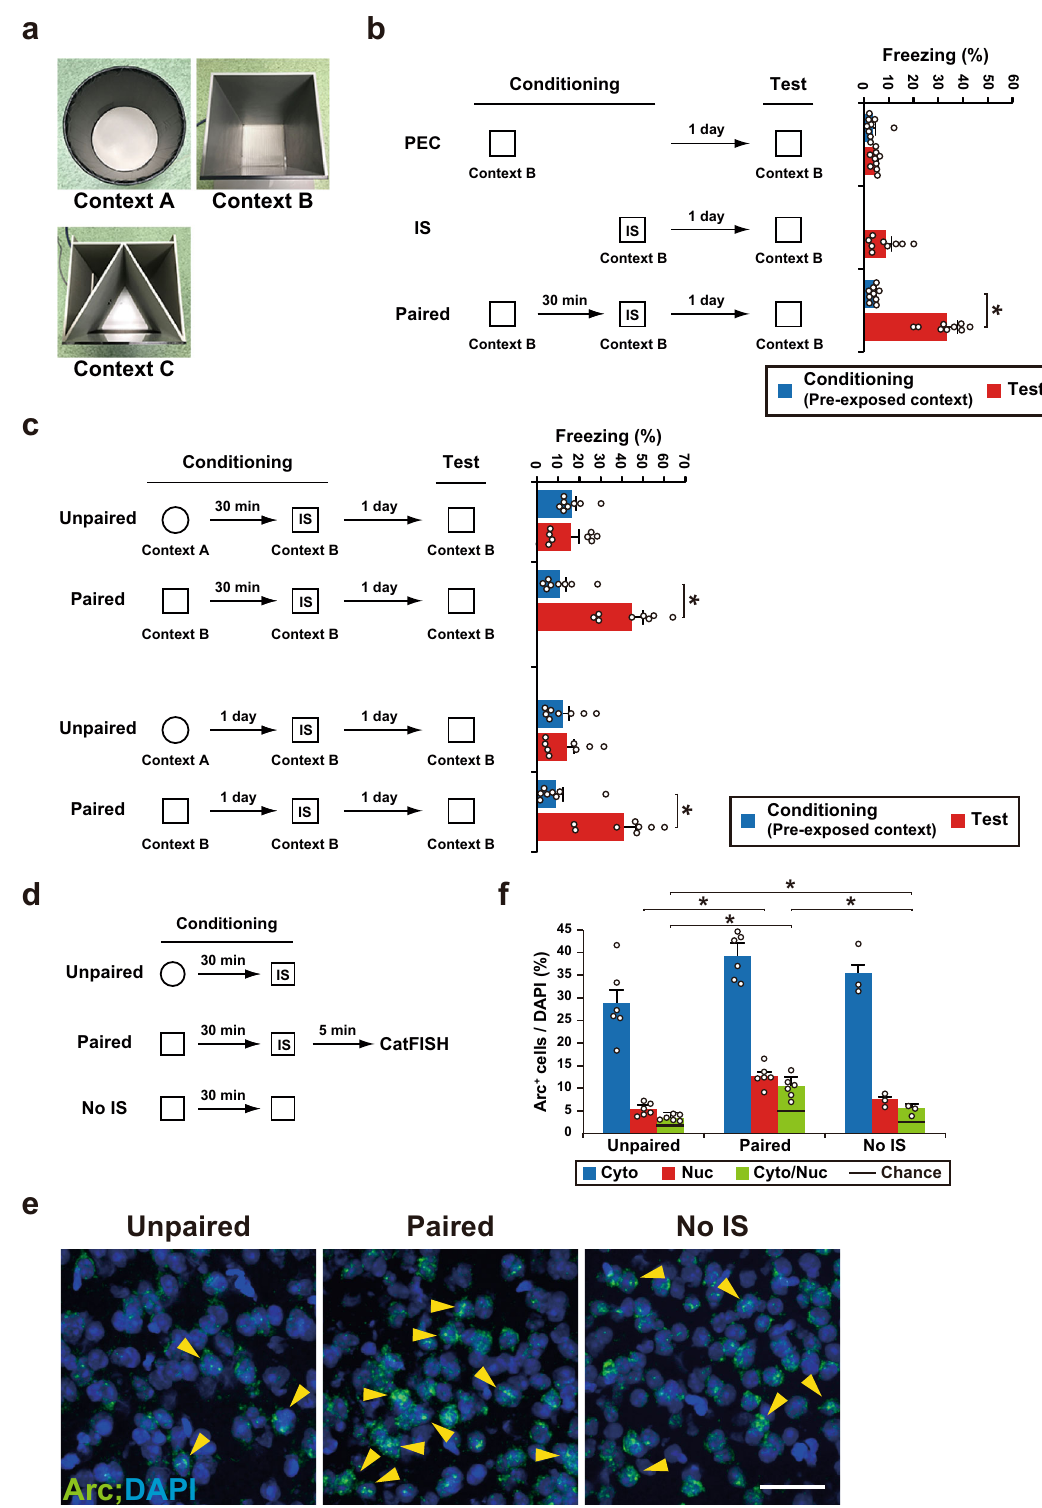
received the paired condition of the CPFE paradigm with optical silencing to the PPC during an IS session in the square context. The circle-labeled group showed signi fi cantly higher freezing in the test session even when optical silencing was delivered to the PPC cell population that responded to the circle context (Fig. 2c). This indicates that cell populations labeled in the PPC are speci fi c to each context.